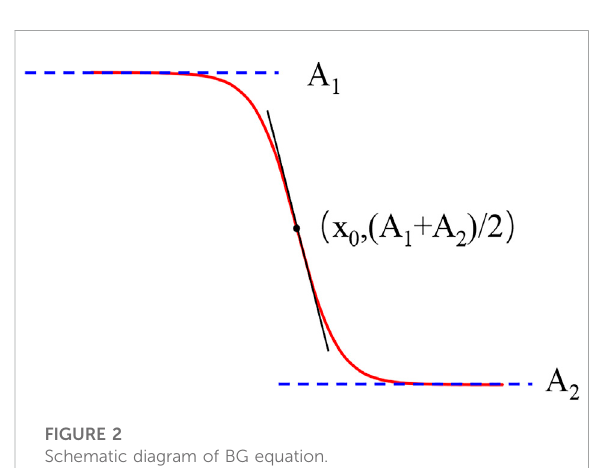
FIGURE 4 Relative permeability curves for different C a